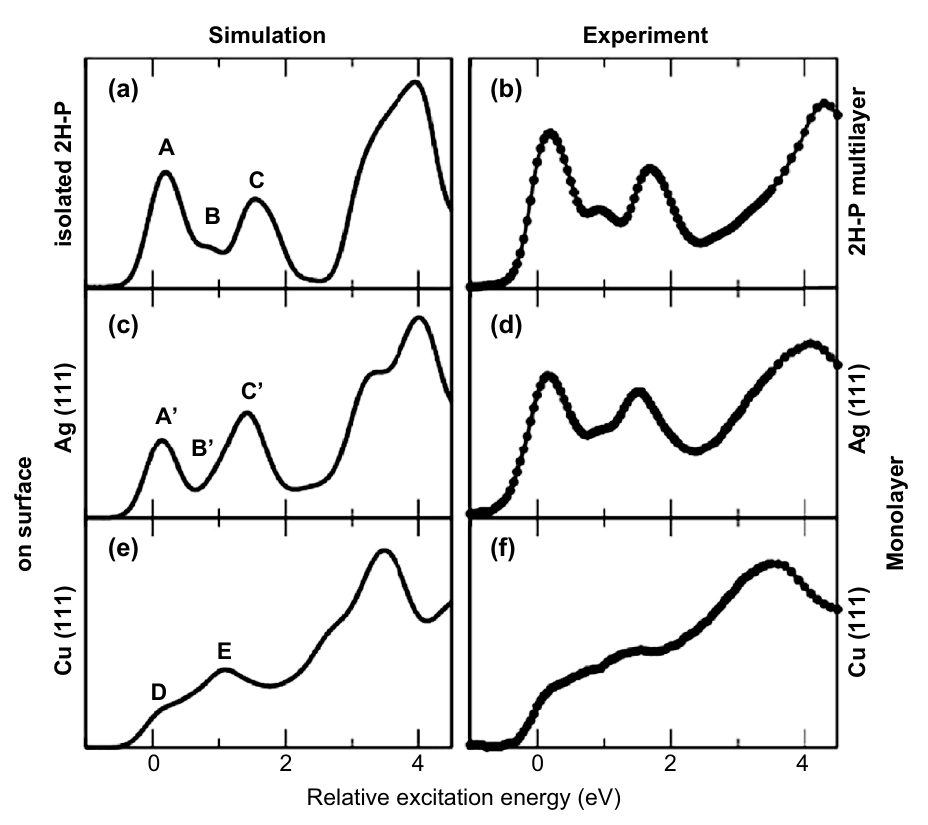
Fig. 4 Comparison of experimental and simulated C K-edge NEXAFS spectra for 2-H porphine adsorbed on Ag(111) and Cu(111). Reprinted with permission from Ref.